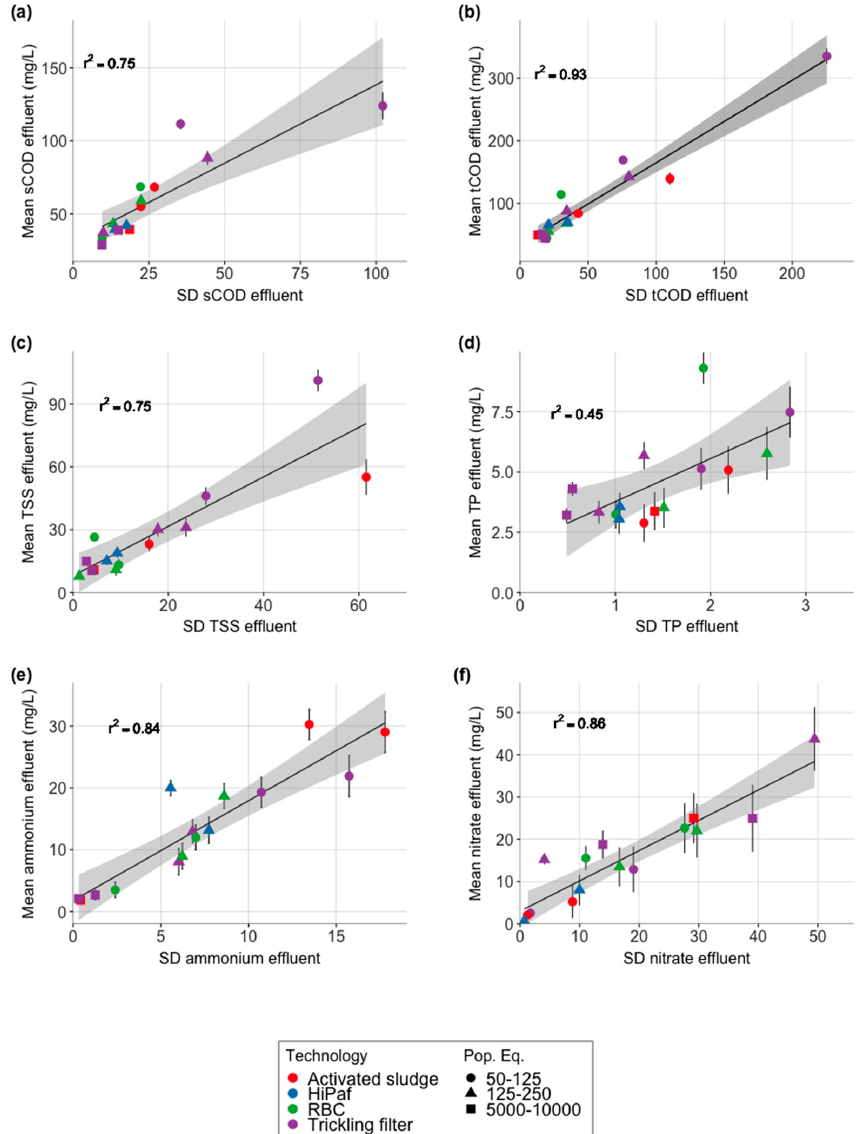
Figure 2. Covariance plots for final e ffl uent values by experimental category as population equivalents and technology type. Colors identify treatment technology type and shape identifies the population equivalence. Error bars show standard error. Shading shows confidence in the linear regression smoothing at the 99th percentile. All correlations (reported as r 2 ) are significant ( p < 0.01). Plot ( a ) is soluble COD; ( b ) is total COD; ( c ) is total suspended solids; ( d ) is total phosphorus; ( e ) is ammonium; and ( f ) is